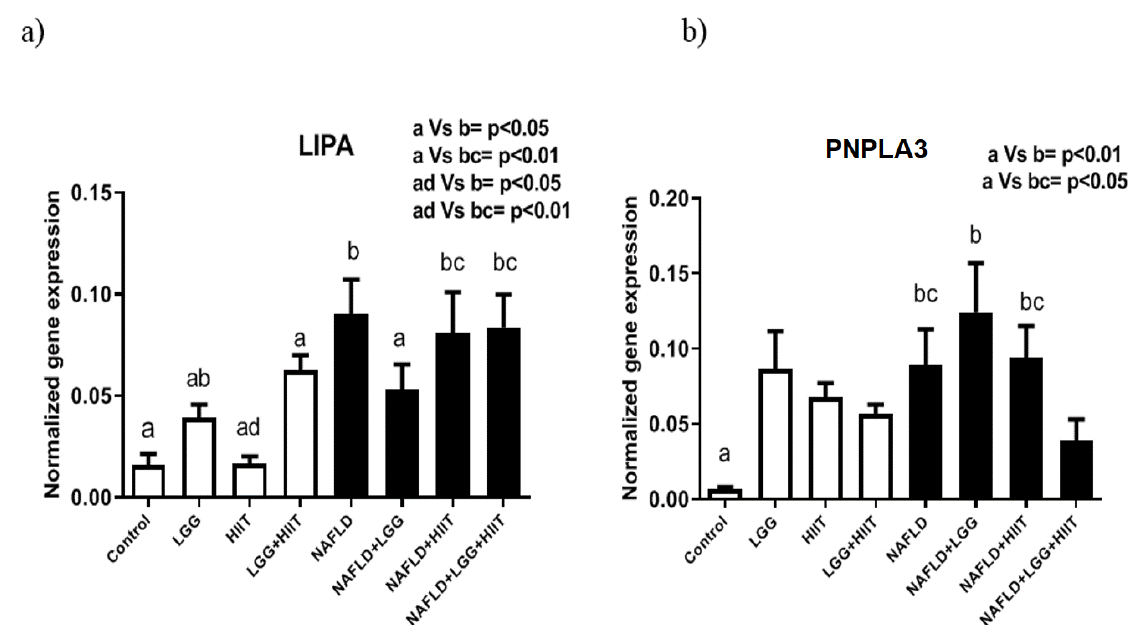
Figure 9: Liver tissue lysosomal acid lipase ( LIPA ) ( a ) and patatinlike phospholipase domain containing 3 ( PNPLA3 ), ( b ) mRNA expression in different groups of study. All values are the mean ± SD (n = 10 per group). Values with different superscripts are significantly different, p < 0.05. LGG: Probiotic L. rhamnosus GG, HIIT: High intensity interval training, NAFLD: Non-alcoholic fatty liver